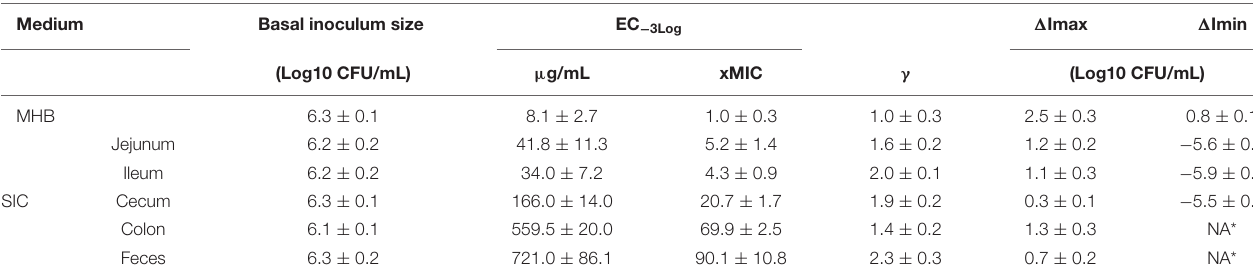
EC − 3log , lowest antibiotic concentration reducing basal bacterial population by 3 Log10 CFU/mL; γ sigmoid coefficient of curve; (cid:49) Imax, maximum growth compared with basal inoculum; (cid:49) Imin, minimum growth (maximum killing) compared with basal inoculum; MIC, minimum inhibitory concentrations (MHB); *, not assessable.